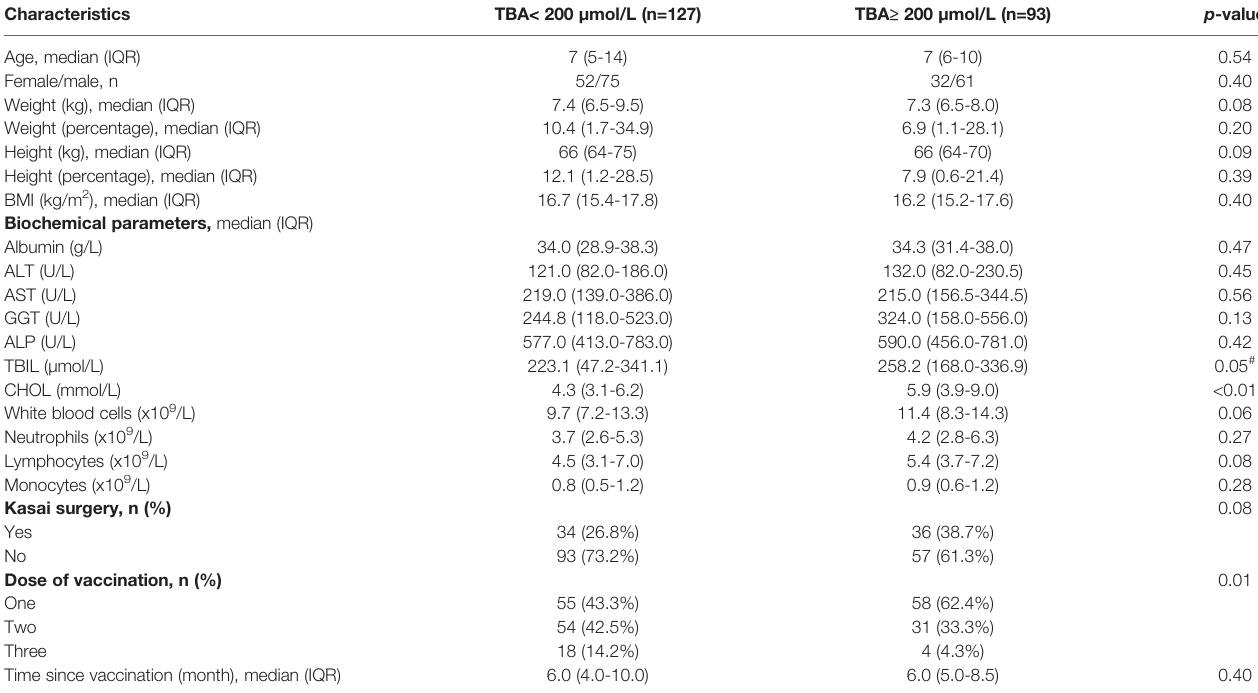
TABLE 4 | Characteristics of patients grouped by TBA. Characteristics